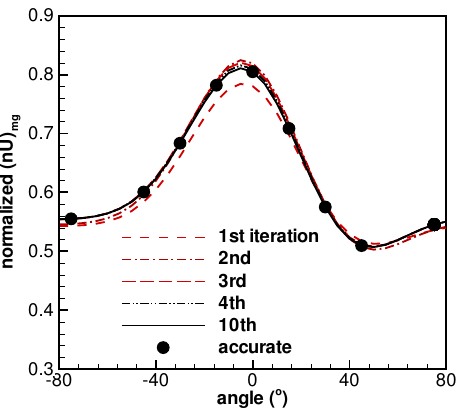
√ 2 RT 0 ) profile development history, along R = 3